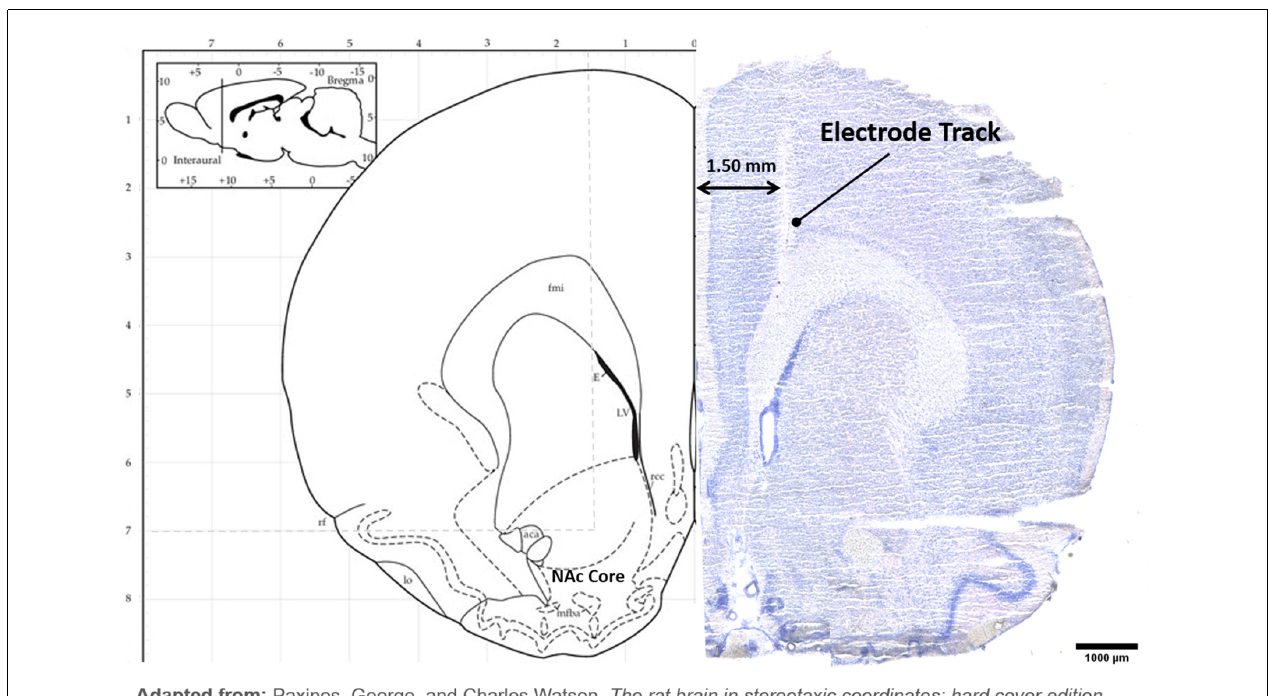
FIGURE 2 | Hybrid image with the left hemisphere of atlas brain (Paxinos and Watson, 2005) at NAc and example of H&E stained brain. (Left): Electrode tip placements are displayed with a black circle in the left hemisphere only for each DBS animal. (Right): DBS electrode tract is imaged terminating in NAc.